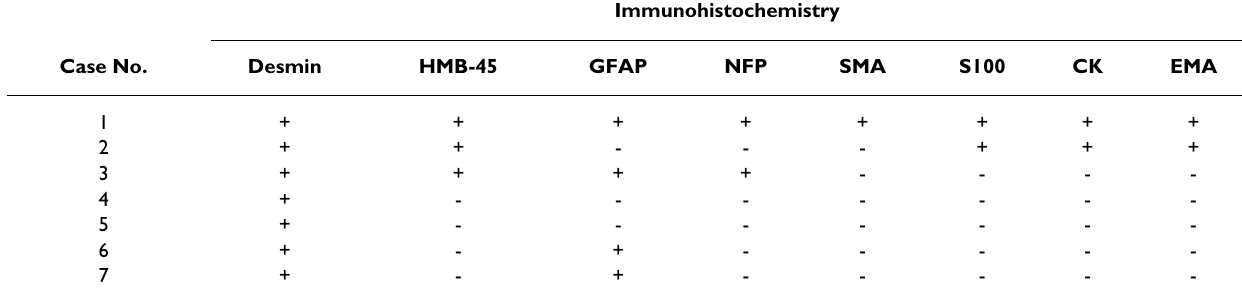
Immunohistochemistry